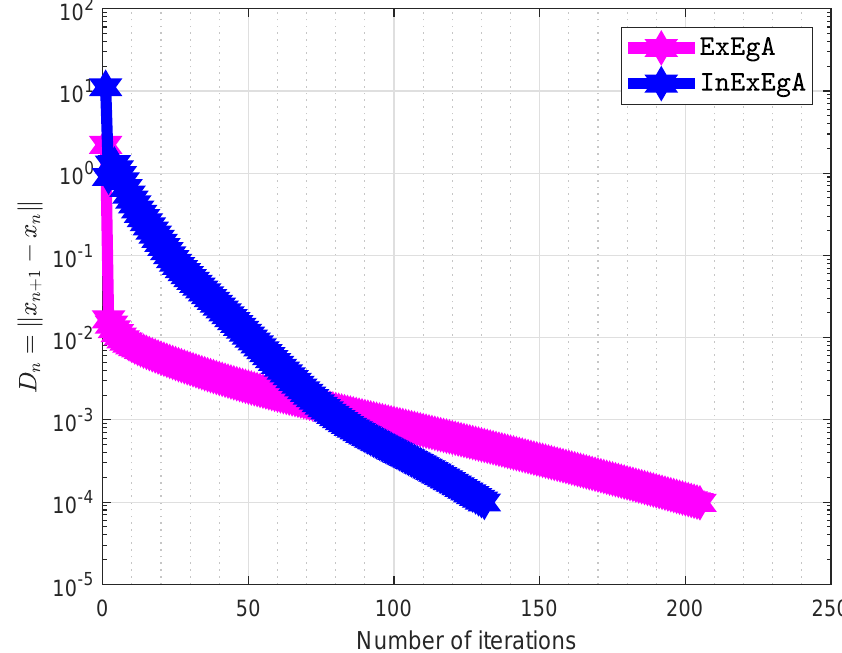
Figure 7. Algorithm 1 comparison with Algorithm 1 in [16] when m = 5.